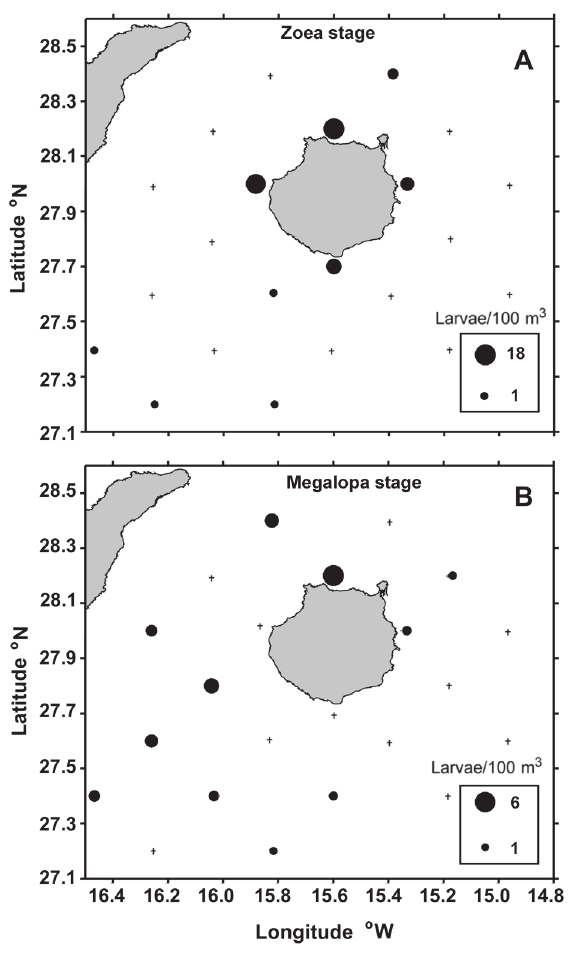
Fig . 6. – Horizontal distribution of neritic decapod larvae abundance (larvae/100 m 3 ) in different larval stages of development. (a) larvae in first zoeal stage; (B) larvae in megalopa stage of development. crosses refer to the sampled stations.